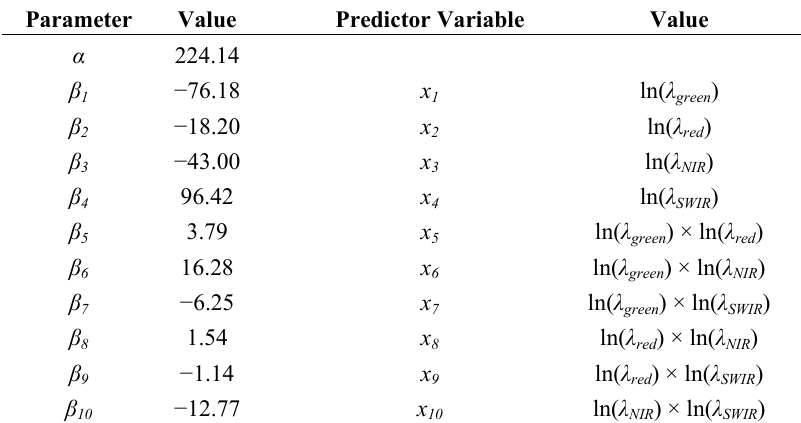
Table 1. Parameters and predictor variables used in the SPOT5 HRG linear discriminant analysis water index (LDAWI). Predictor variables are calculated from the surface reflectance ( λ ) of each band (green, red, NIR and SWIR), where ln is the natural